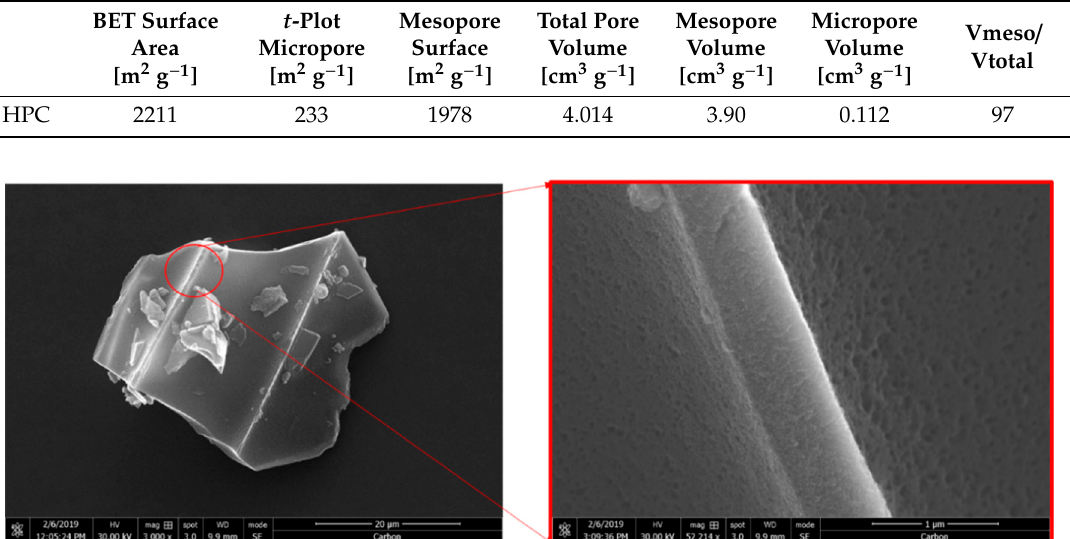
Table 1. Textural characteristics of hierarchical porous carbon (HPC).